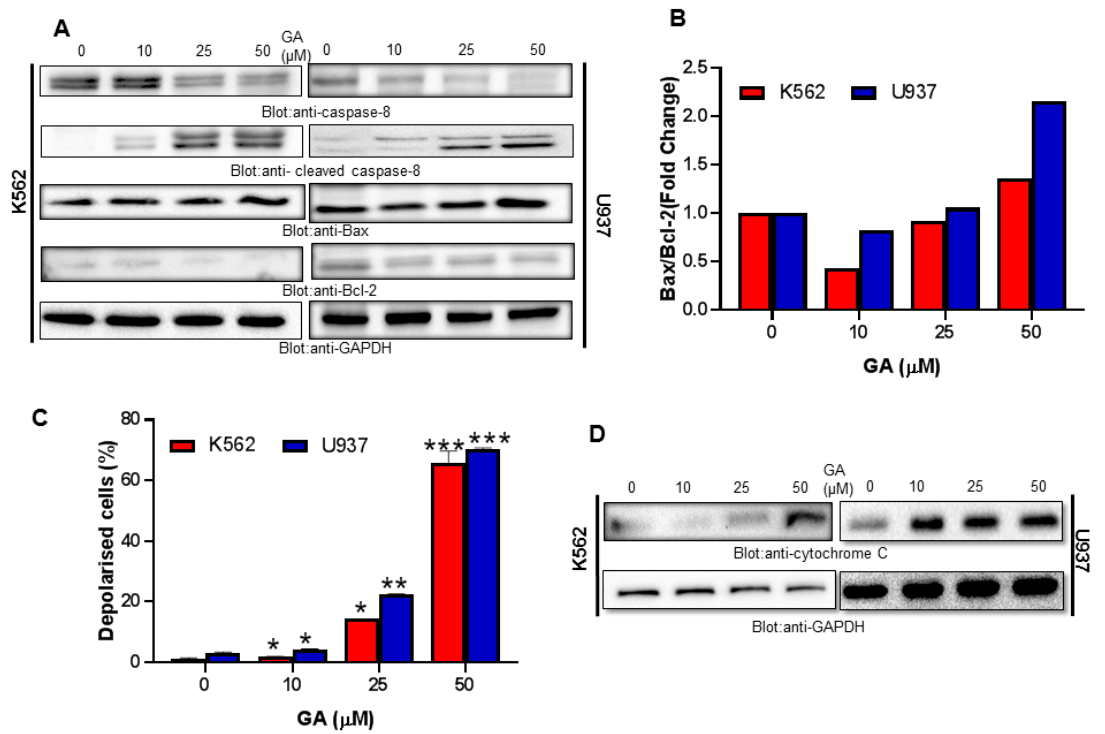
Figure 5. Greensporone A-induced mitochondrial signaling pathways in leukemic cells.